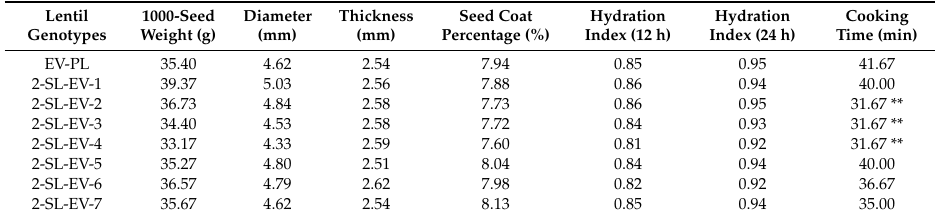
Table 6. Agronomical, morphological, seed coat %, hydration index, and cooking time of the parental landrace “Evros” and second-generation sister lines originating from